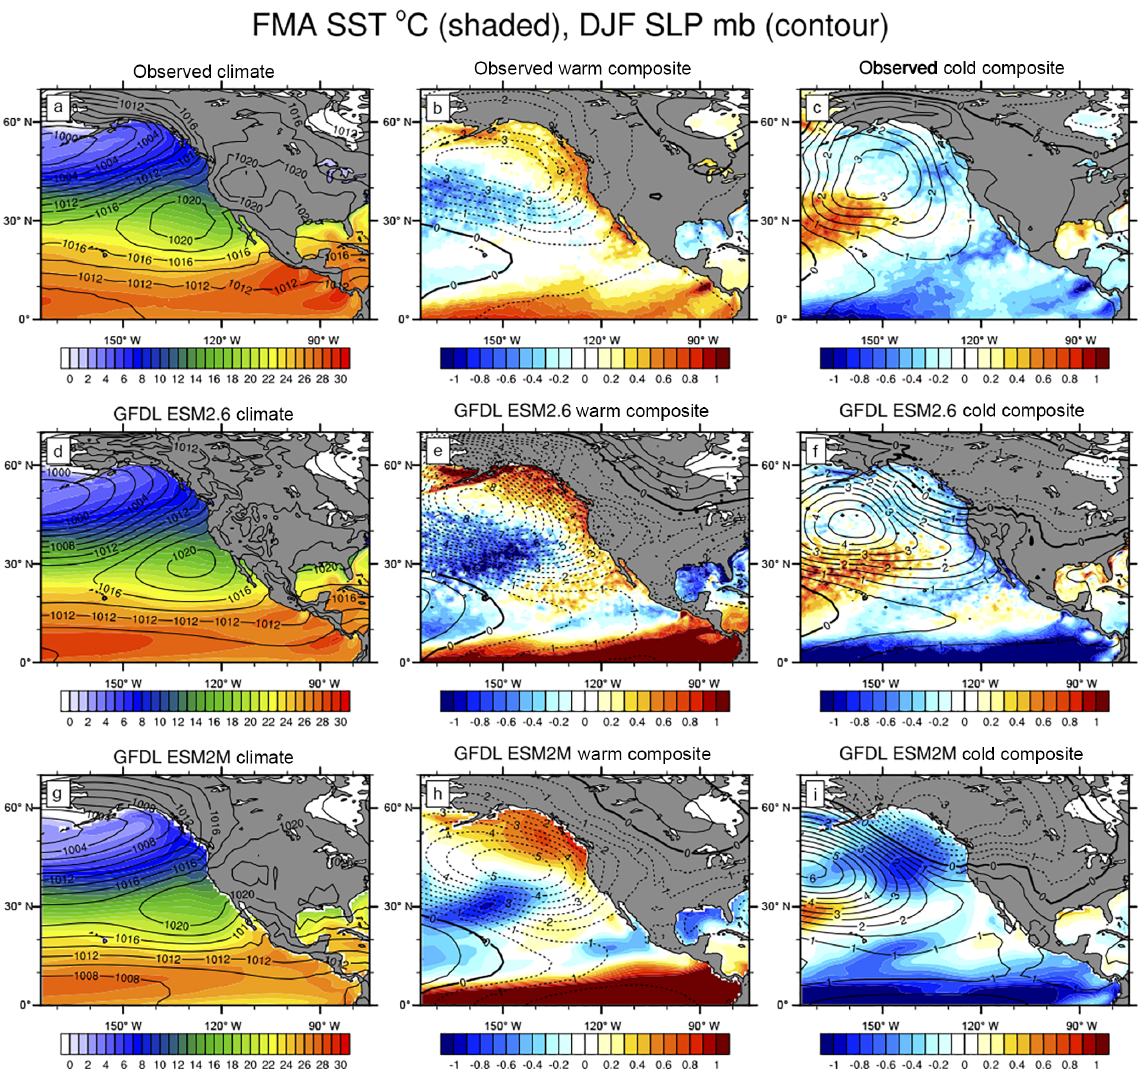
Figure 1. February–March–April (FMA) sea surface temperature ( ◦ C, shaded) and DJF sea level pressure (mb, contour) in the eastern North Pacific: ( a , d , and g ) climatology (4mb contour interval), ( b , e , and h ) El Niño/warm high-pass composite (0.5mb contour interval), and ( c , f , and i ) La Niña/cold high-pass composite (0.5mb contour interval) for (a–c) observations (sea surface temperature: Hadley Centre Sea Ice and Sea Surface Temperature data set (HadISST); sea level pressure: NCEP reanalysis), (d–f) ESM2.6, and (g–i)